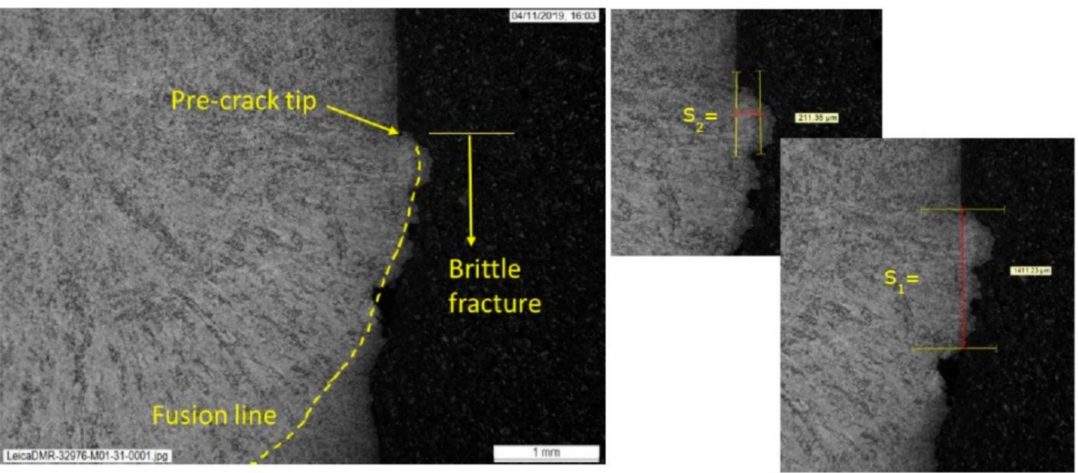
Figure 12. Example of post-test metallography from specimen W01-31, characterizing the distance of the crack tip from the fusion line, in terms of s1 and s2.